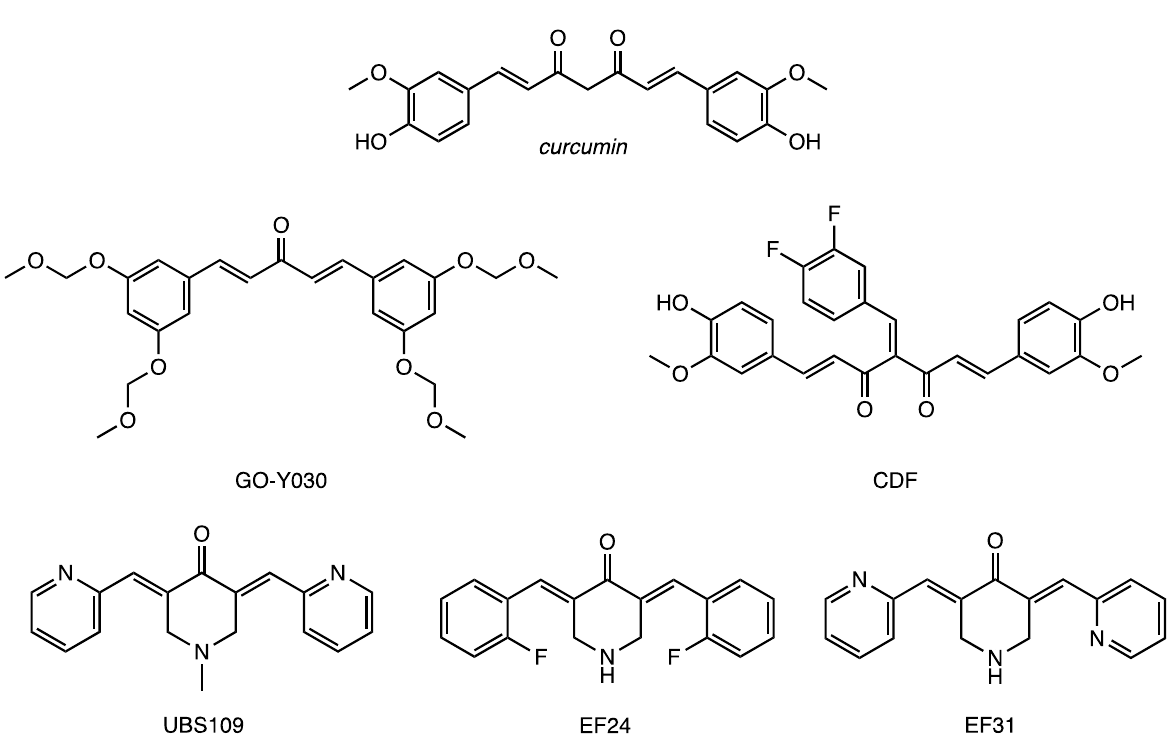
Figure 6. Curcumin and curcumin-like biologically active compounds.